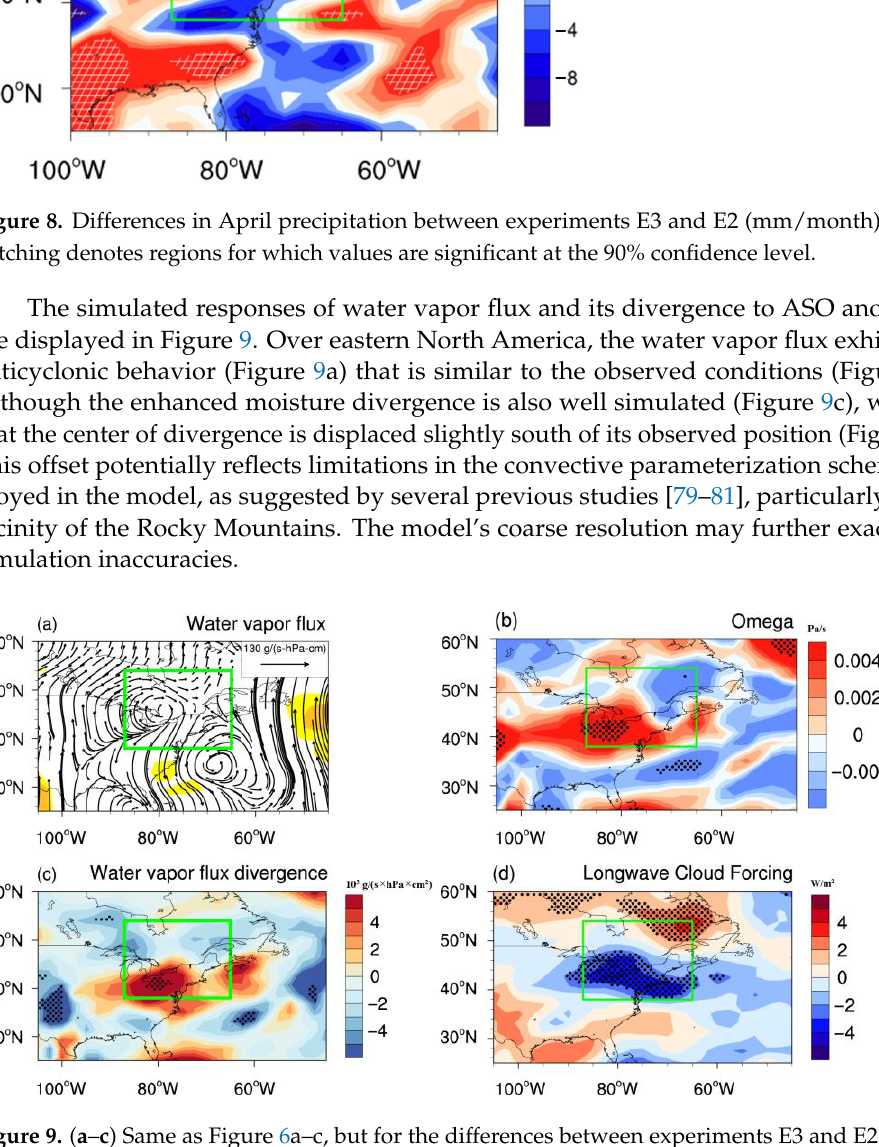
Figure 7. ( a ) Climatological distribution of April rainfall (mm/month) in the control experiment